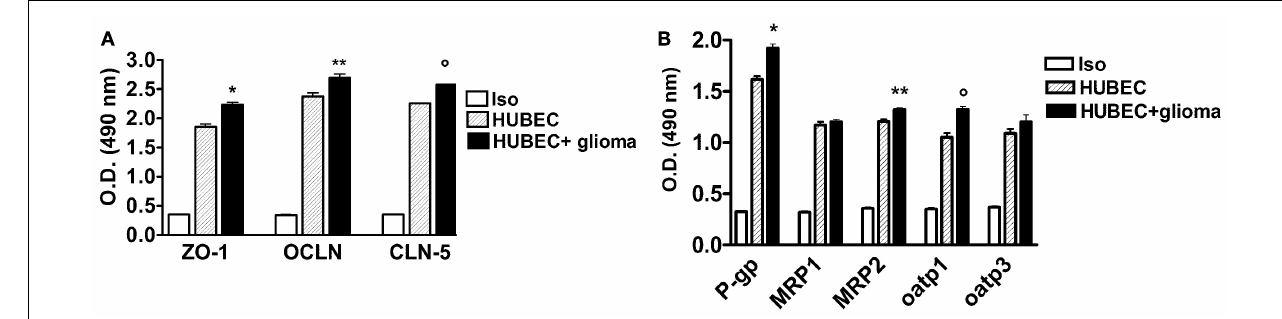
the presence or absence of glioma cells.The results are shown as mean ± SEM of optical density (OD) values of duplicate batches of three independent cultures from three different tumors listed in Table 1 ( n = 3). Iso, antibody isotype; P-gp, P-glycoprotein; MRP-1, multidrug resistance protein-1; MRP-2, multidrug resistance protein-2; oatp1, organic anion-transporting polypeptide-1; oatp3, organic anion-transporting (paired t